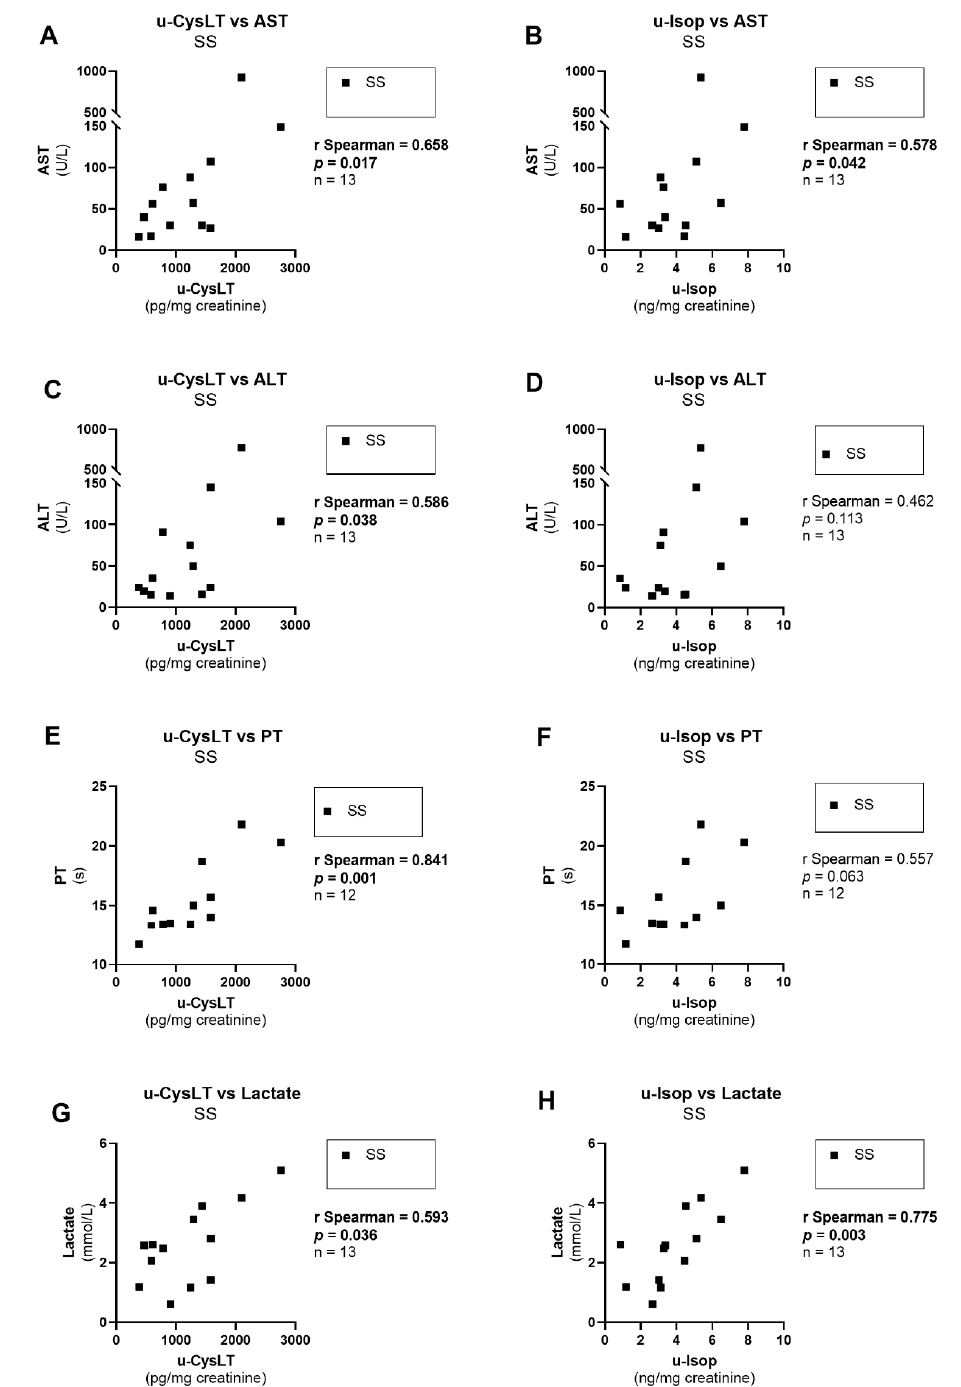
Figure 9. Correlations for u-CysLT or u-Isop with hepatic biomarkers and lactate at admission in SS patients: ( A ) u-CysLT vs. AST; ( B ) u-Isop vs. AST; ( C ) u-CysLT vs. ALT; ( D ) u-Isop vs. ALT; ( E ) u-CysLT vs. PT; ( F ) u-Isop vs. PT; ( G ) u-CysLT vs. lactate; ( H ) u-Isop vs. lactate. ALT, alanine aminotransferase; AST, aspartate aminotransferase; u-CysLT, urinary cysteinyl leukotrienes; u-Isop, urinary isoprostanes. The values of u-CysLT and u-Isop were corrected for the respective urinary creatinine concentrations.